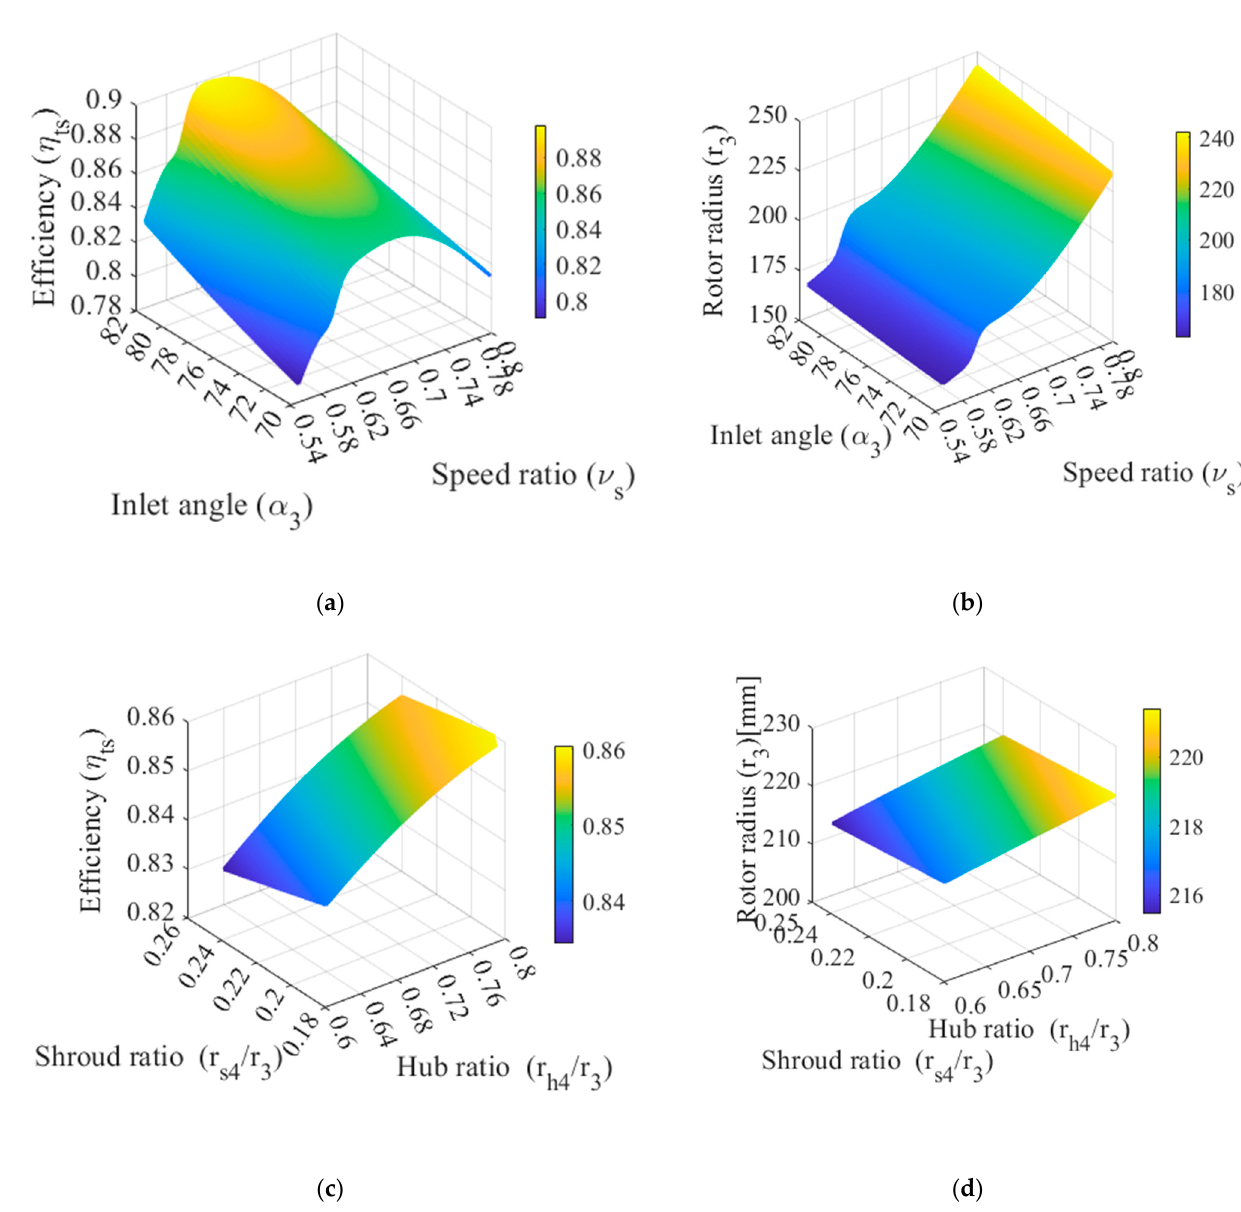
Figure 14. ( a ) Response surface of turbine’s efficiency to inlet flow angle and speed ratio. ( b ) Response surface of turbine’s rotor size to inlet flow angle and speed ratio ( c ) Response surface of turbine’s efficiency to shroud ratio and hub ratio ( d ) Response surface of turbine’s rotor size to shroud ratio and hub ratio.